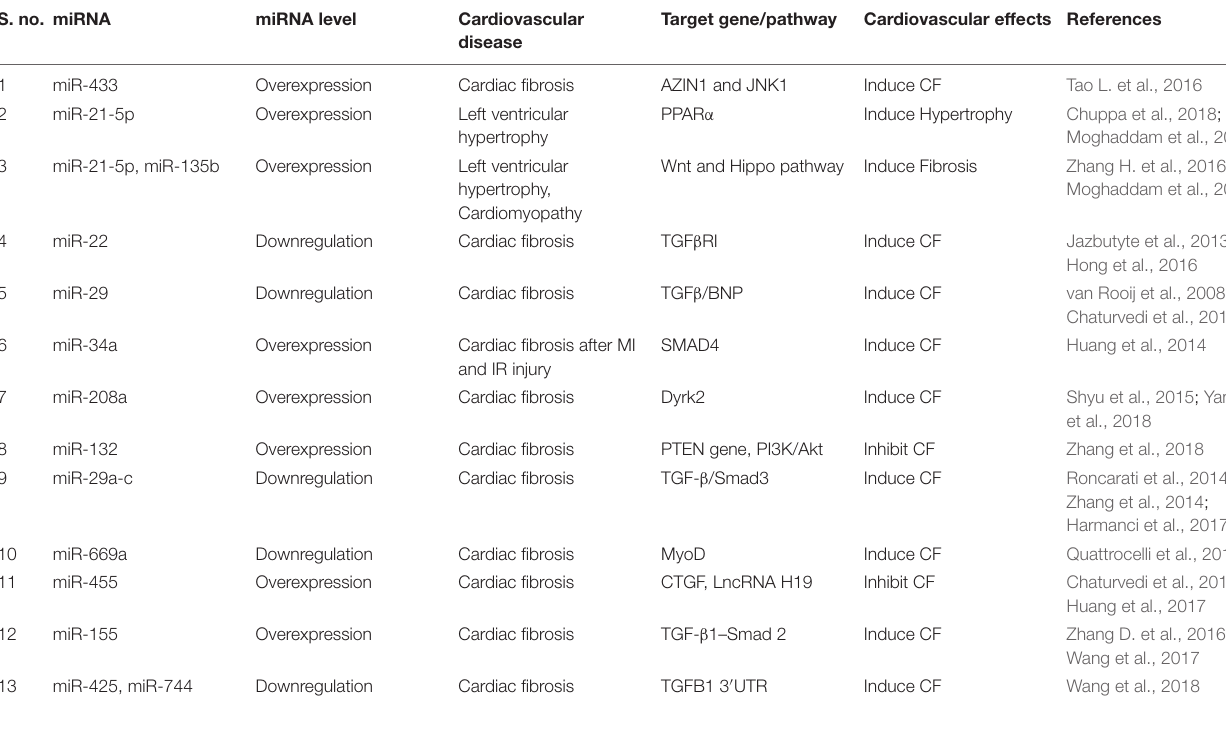
TABLE 1 | Regulatory miRNAs associated with cardiac